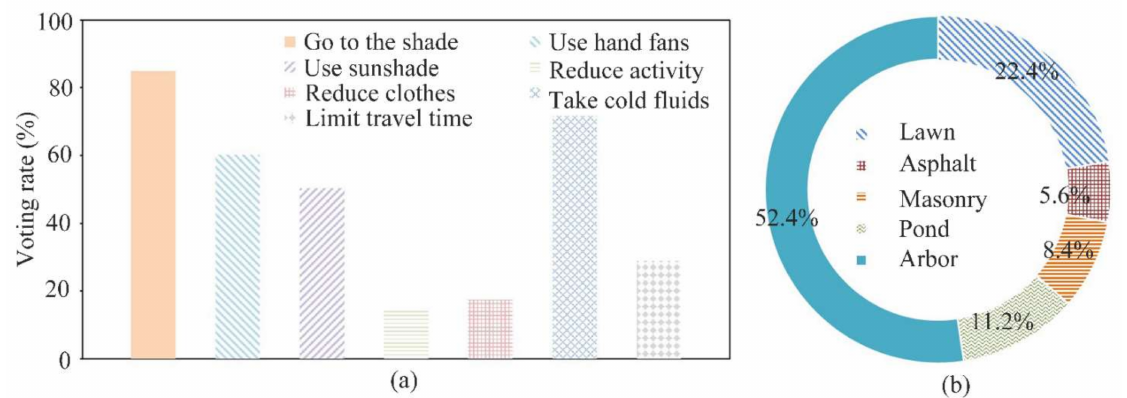
Figure 10. ( a ) External manifestation of thermal adaptation and ( b ) the most popular cool place according to respondents’